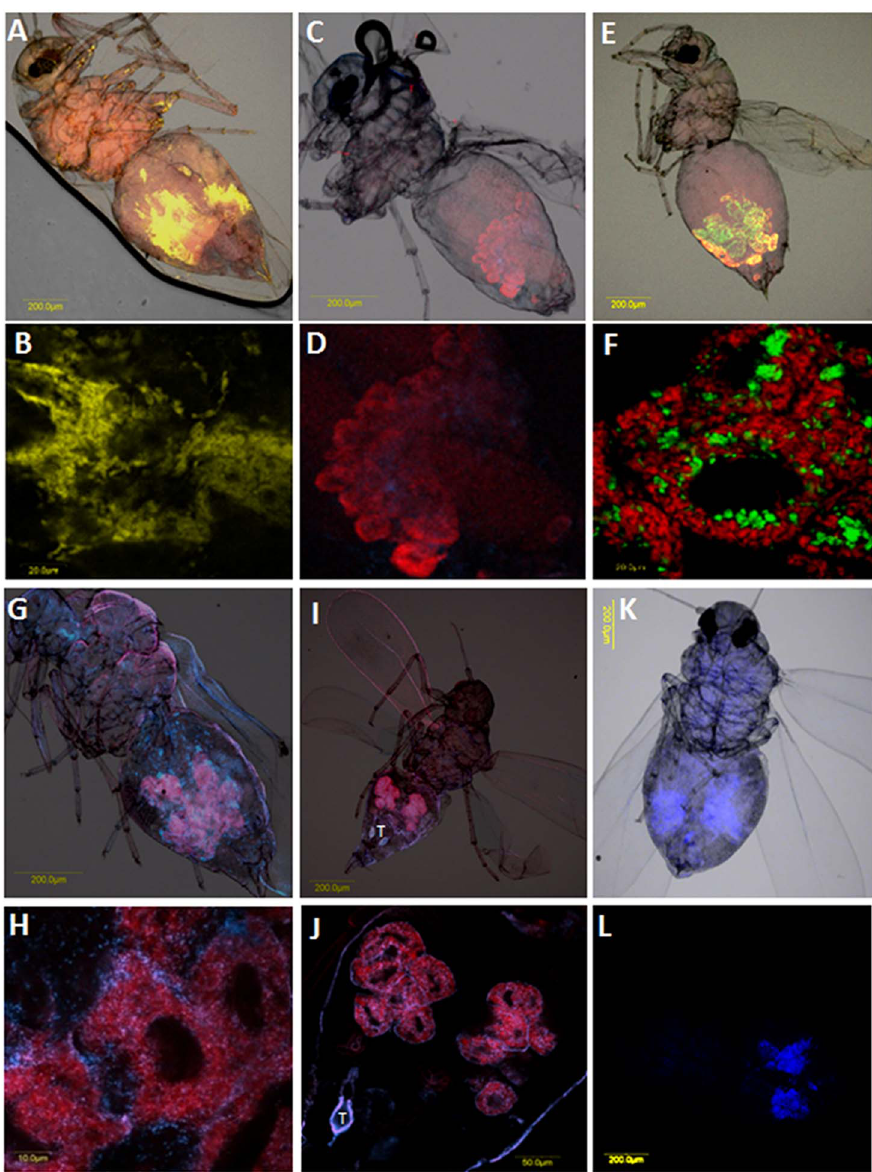
Figure 3. FISH of selected specimens collected in this study for specific localization of secondary endosymbionts. A–B: FISH of Arsenophonus (yellow) and Portiera (red) in T. vaporariorum under bright field (A) and dark field (B). C–D: FISH of Fritschea (blue) and Portiera (red) in NW2 under bright field (C) and dark field (D). E–F: FISH of Hamiltonella (green) and Portiera (red) in MEAM1 under bright field (E) and dark field (F). G– H: FISH of Rickettsia (blue) and Portiera (red) in MEAM1 under bright field (G) and dark field (H). I–J: FISH of Cardinium (blue) and Portiera (red) in T. acaciae under bright field (I) and dark field (J). K–L: FISH of Wolbachia (blue) in B. tuberculata under bright field (K) and dark field (L). T: testicle.